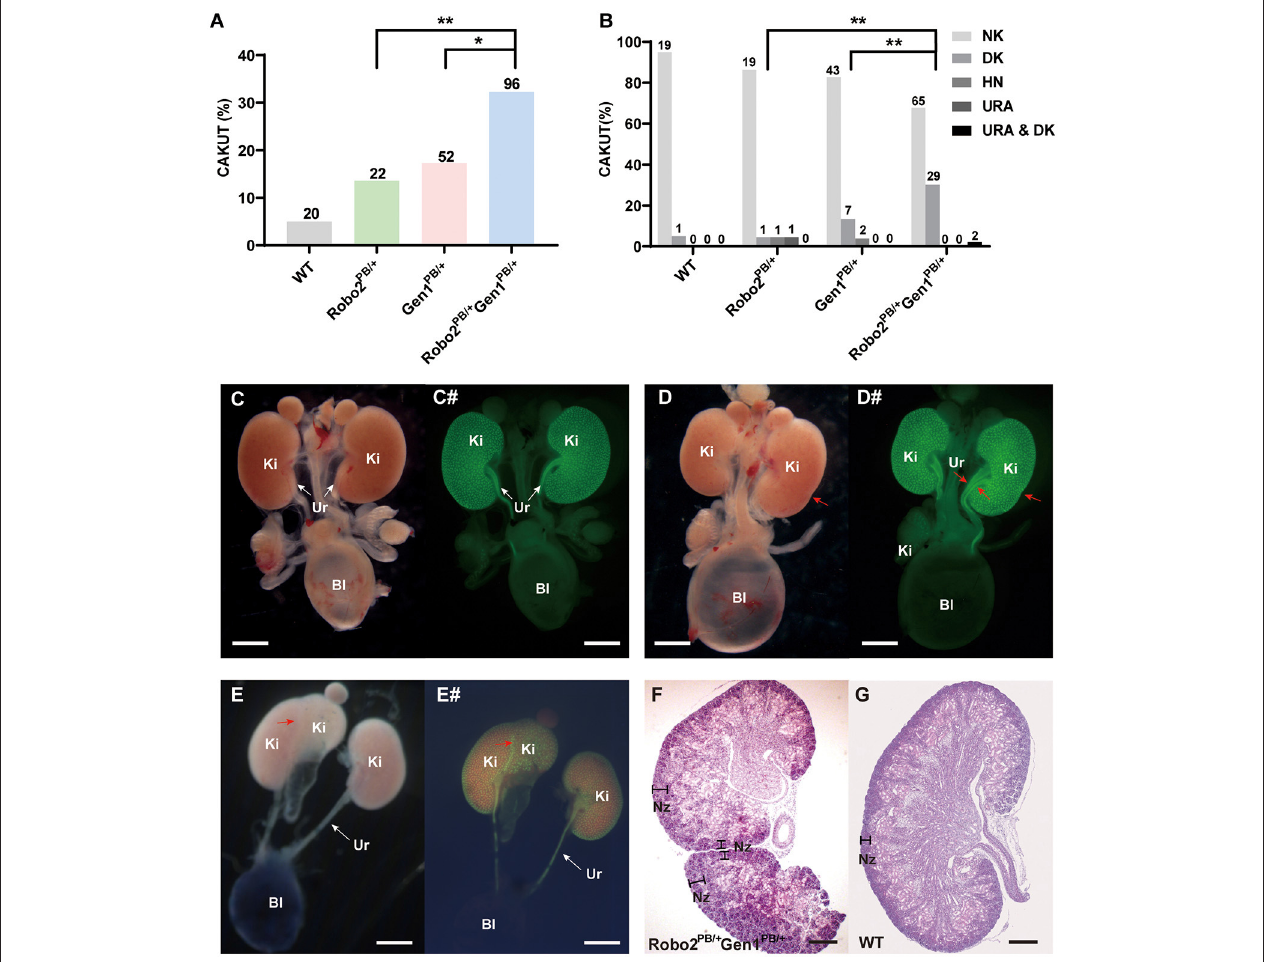
FIGURE 2 | Analysis of newborn mouse phenotypes in the four groups at P0.5. (A) Summary of the kidney symptoms in the four groups. (B) Percentages of newborn mice with a number of normal kidneys (NK), duplex kidneys (DK), hydronephrosis (HN), unilateral renal agenesis (URA) and hydronephrosis complicated with duplex kidneys (HN & DK). The number n represents the number of cases. (C–E) Representative images of the normal kidney (C) , duplex kidney (D) , and hydronephrosis complicated with duplex kidney (E) . (C#–E#) Representative images visualized by staining for Hoxb7 expression in normal kidneys (C#) , duplex kidneys (D#) , and hydronephrosis complicated with duplex kidneys (E#) . Red arrowheads in (D–E#) indicate abnormal nephrogenic zones of the duplex kidney and double ureters. White arrows indicate the normal ureter. (F,G) Histological sections of P0.5 Robo2 PB / + Gen1 PB / + (F) and WT kidneys (G) stained with hematoxylin and eosin. The region where nephrogenesis occurs (nephrogenic zone) indicated by black lines is restricted to the periphery in the WT kidney but extends toward the inner cortex of the Robo2 PB / + Gen1 PB / + kidney. Scale bars, 2mm in (C–E#) ; 200 µ m in (F,G) . NK, normal kidney; DK, duplex kidney; URA, unilateral renal agenesis; HN, hydronephrosis; Bl, bladder; Ki, kidney; Ur, ureter; Nz, nephrogenic zone; NS, non-significant; * P < 0.05; ** P < 0.001.